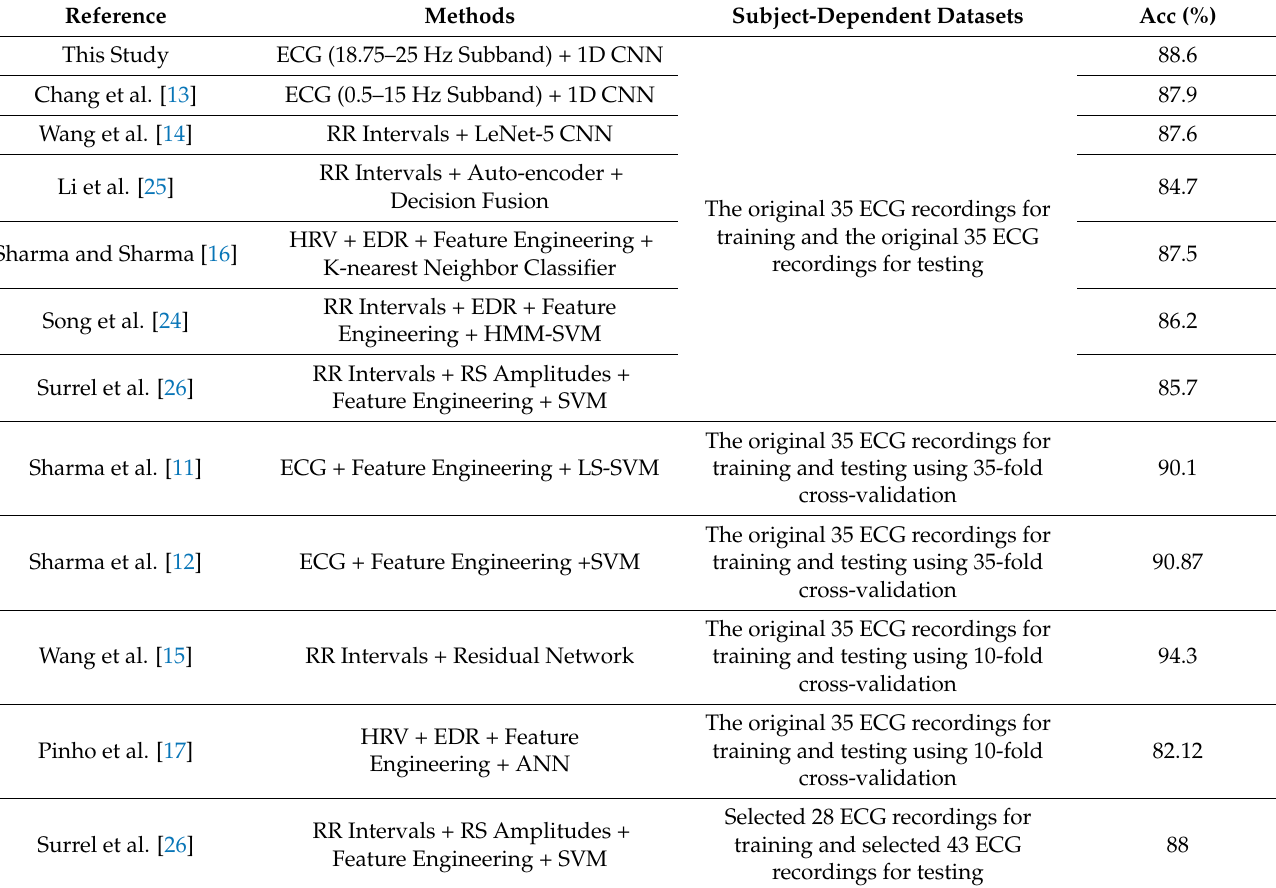
Table 5. Comparison of the method and performance of the proposed 1D CNN model with the previous studies for the per-minute apnea detection using subject-dependent datasets from the MIT PhysioNet Apnea-ECG